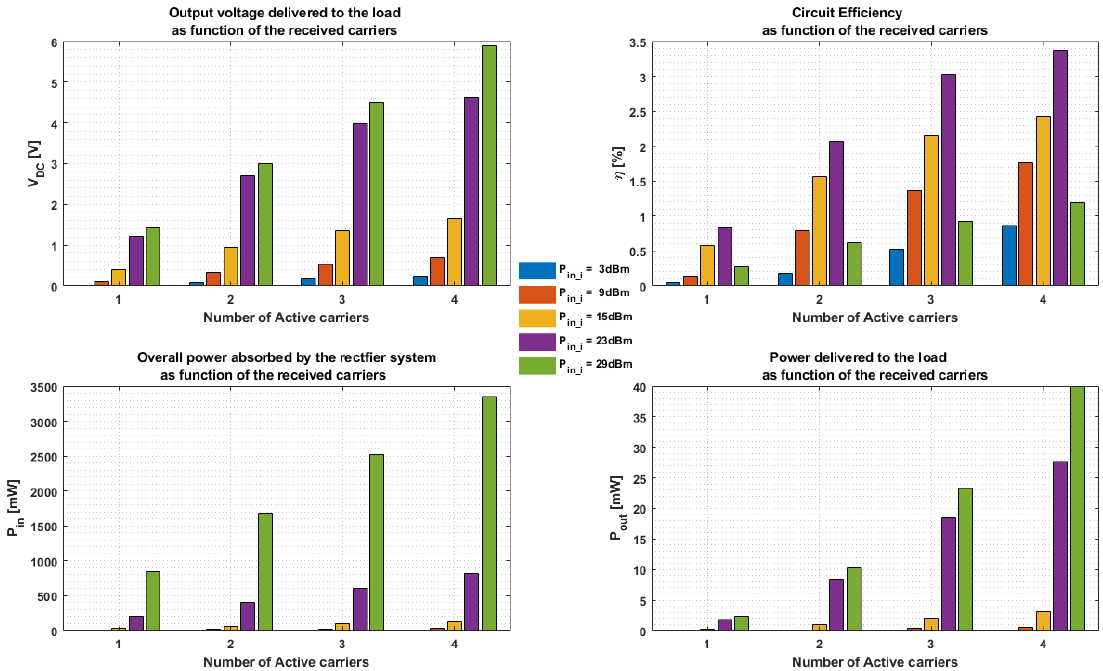
Figure 7. Characterization of the proposed WPT